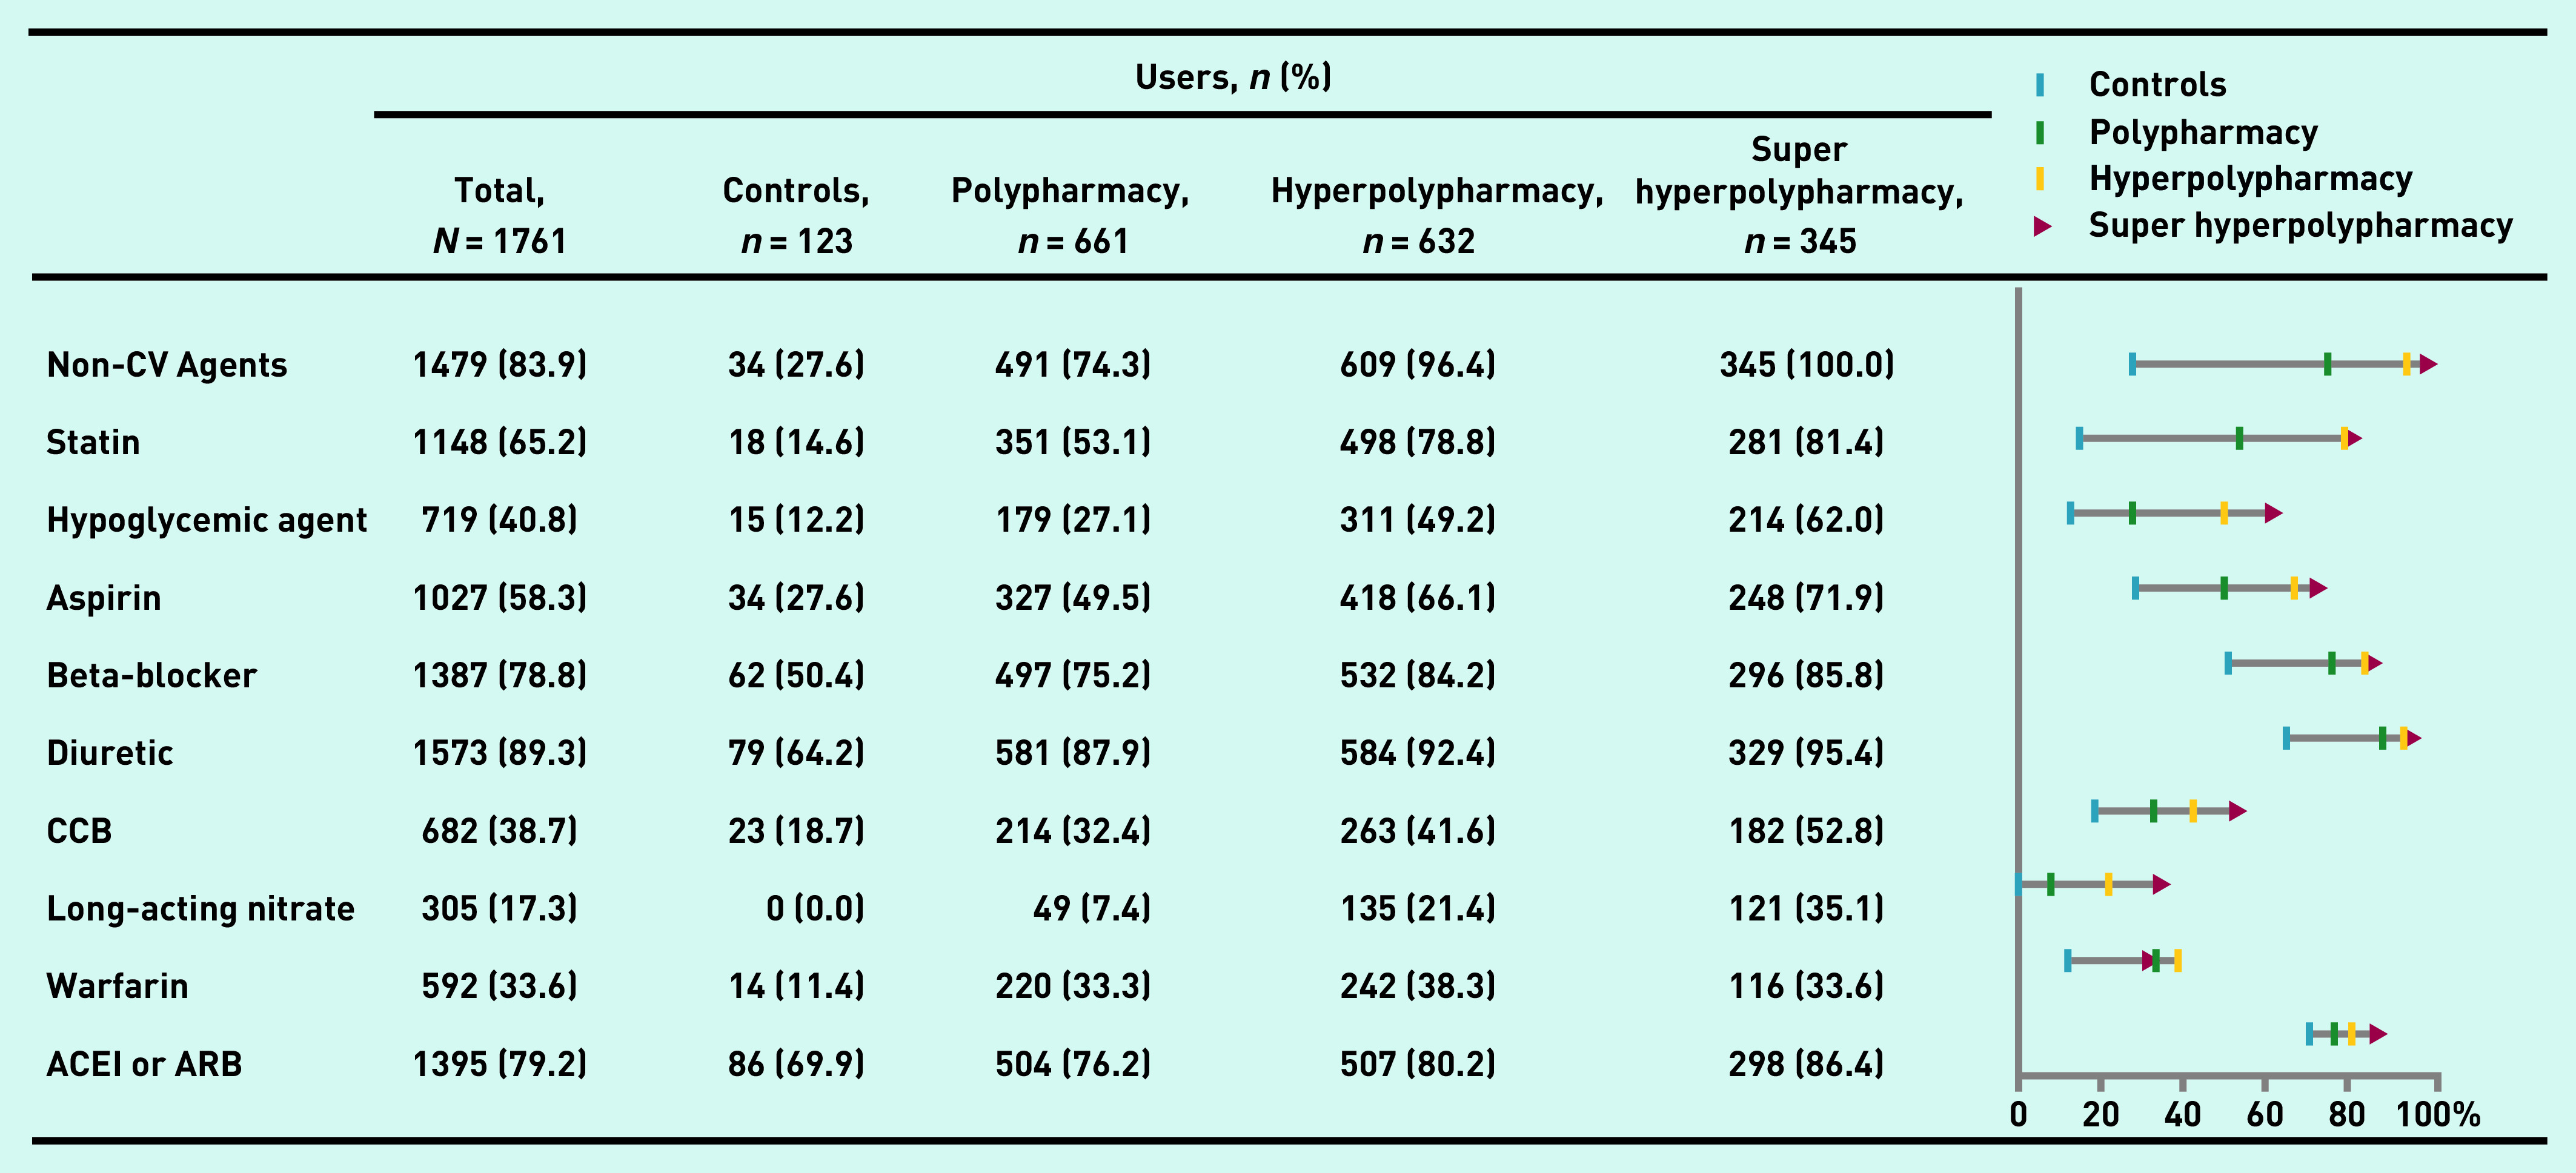
Medication usage characteristics in different medication burden status. ACEI = angiotensin-converting enzyme inhibitor. ARB = angiotensin receptor blocker. CCB = calcium channel blocker. CV = cardiovascular.